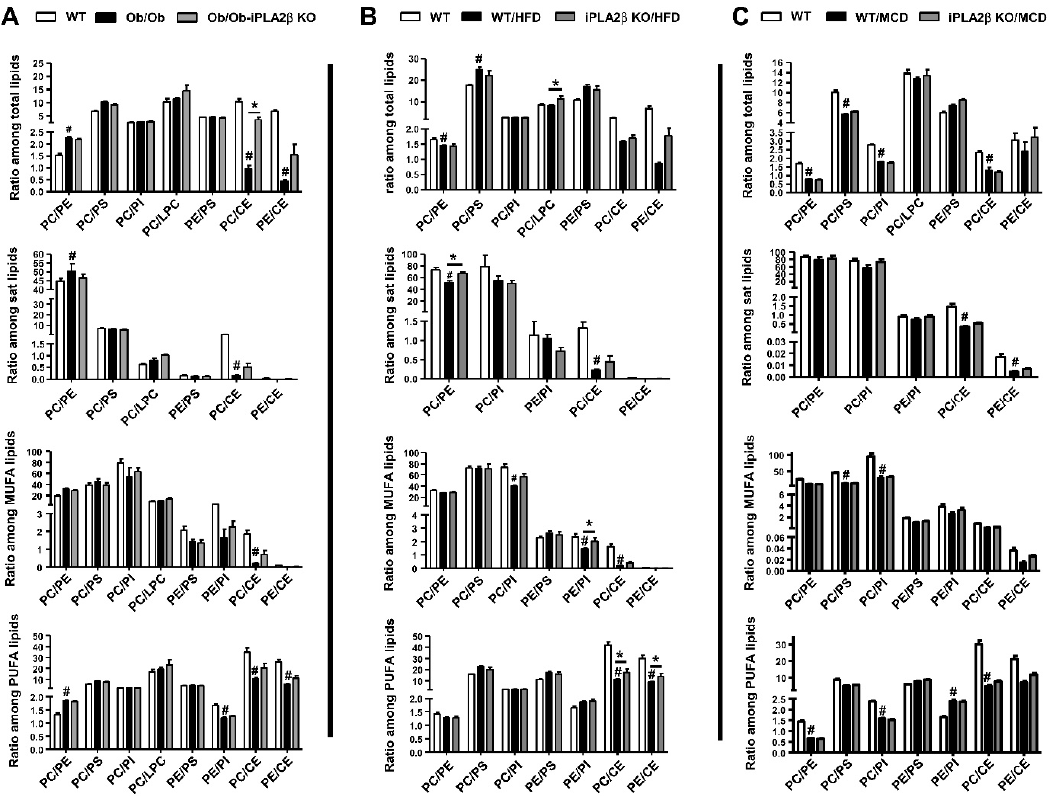
Figure 7. Alters the ratios among phospholipid subclasses in 3 NAFLD models: Ob / Ob mice, HFD-, and MCD-fed mice. Ob / Ob mice, HFD-, and MCD-fed mice are described in Figures 1, 3 and 5, respectively. The ratio among PLs in livers of ( A ) Ob / Ob, ( B ) HFD-fed mice, and ( C ) MCD-fed mice. Data are mean ± SEM, N = 5–7 for ( A ); N = 4–5 for ( B ), and N = 5–6 for ( C ). #, p < 0.05, versus WT; *, p < 0.05, Ob / Ob versus Ob / Ob-iPLA 2 β KO or WT / HFD versus iPLA 2 β KO / HFD.